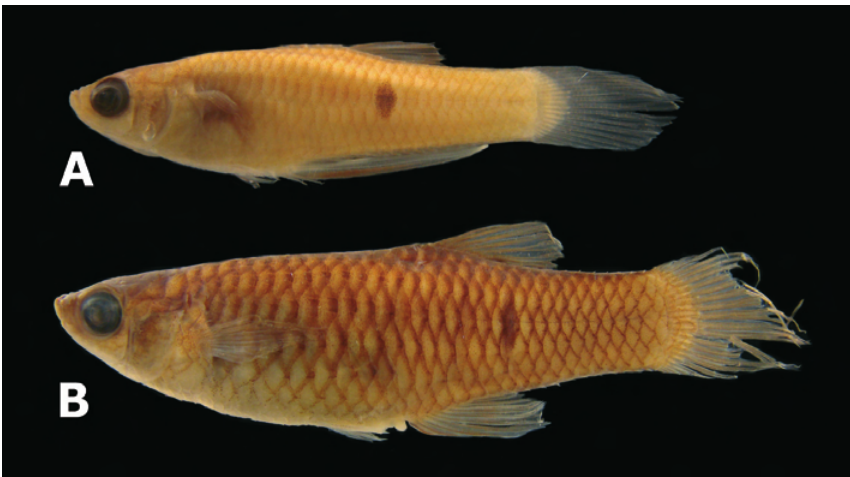
Fig. 25. Phalloceros titthos . (A) Male, 17.1 mm SL, USNM 297945, rio da Praia, near Guaratuba; (B) holotype, female, 35.9 mm SL, MZUSP 79670, creek near beach, Guaratuba, Paraná, Brazil.